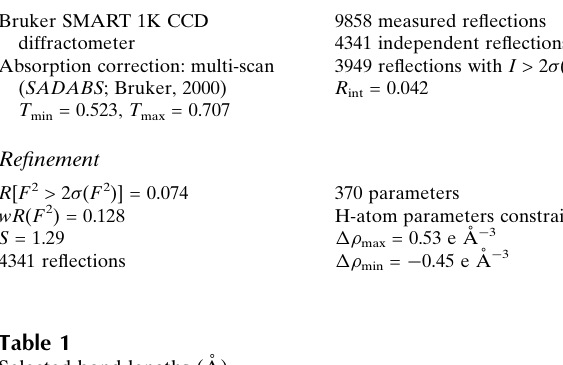
Selected bond lengths (A˚ ).